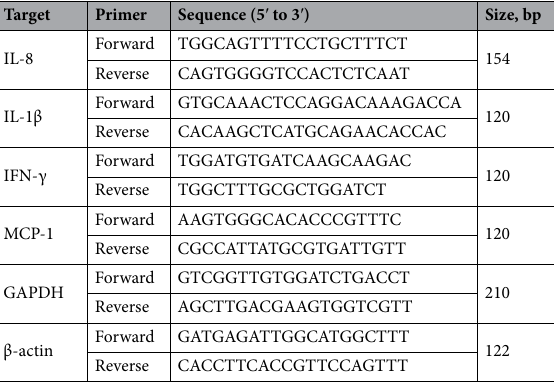
and 4 ′ ,6-diamidino-2-phenylinodele for nuclei (Immunobioscience, Raleigh, USA). Images was captured using a laser scanning confocal microscope, LSM700 (Carl Zeiss, Jena, Germany).